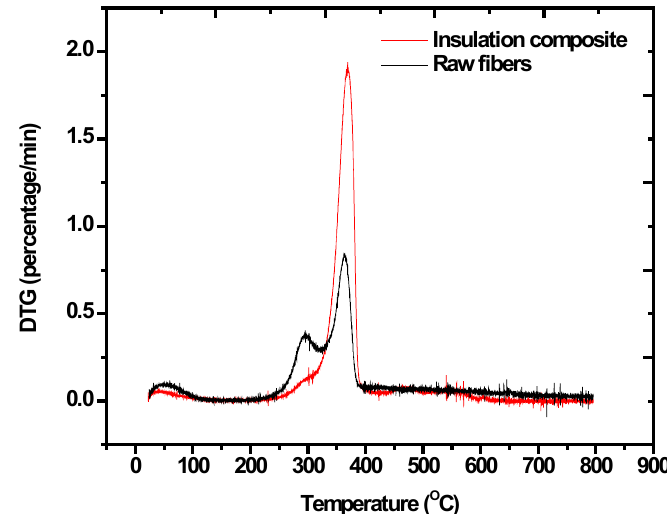
Figure 10. DTG of raw fibers and the insulation composite. Table 5. Thermal characteristics of raw fibers and insulation composite.